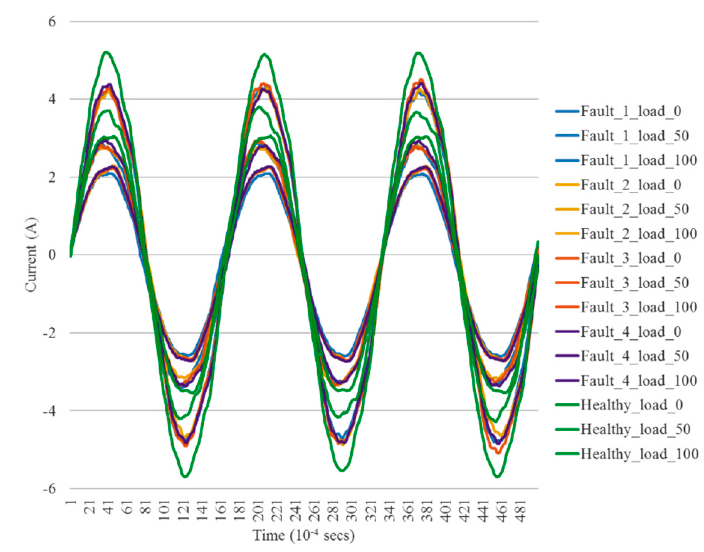
( d ) Figure 1. Four synthetically prepared motor fault conditions: ( a ) bearing axis misalignment; ( b ) stator inter-turn short circuiting; ( c ) broken rotor strip; and ( d ) outer ring bearing damage. 3. Data Preprocessing